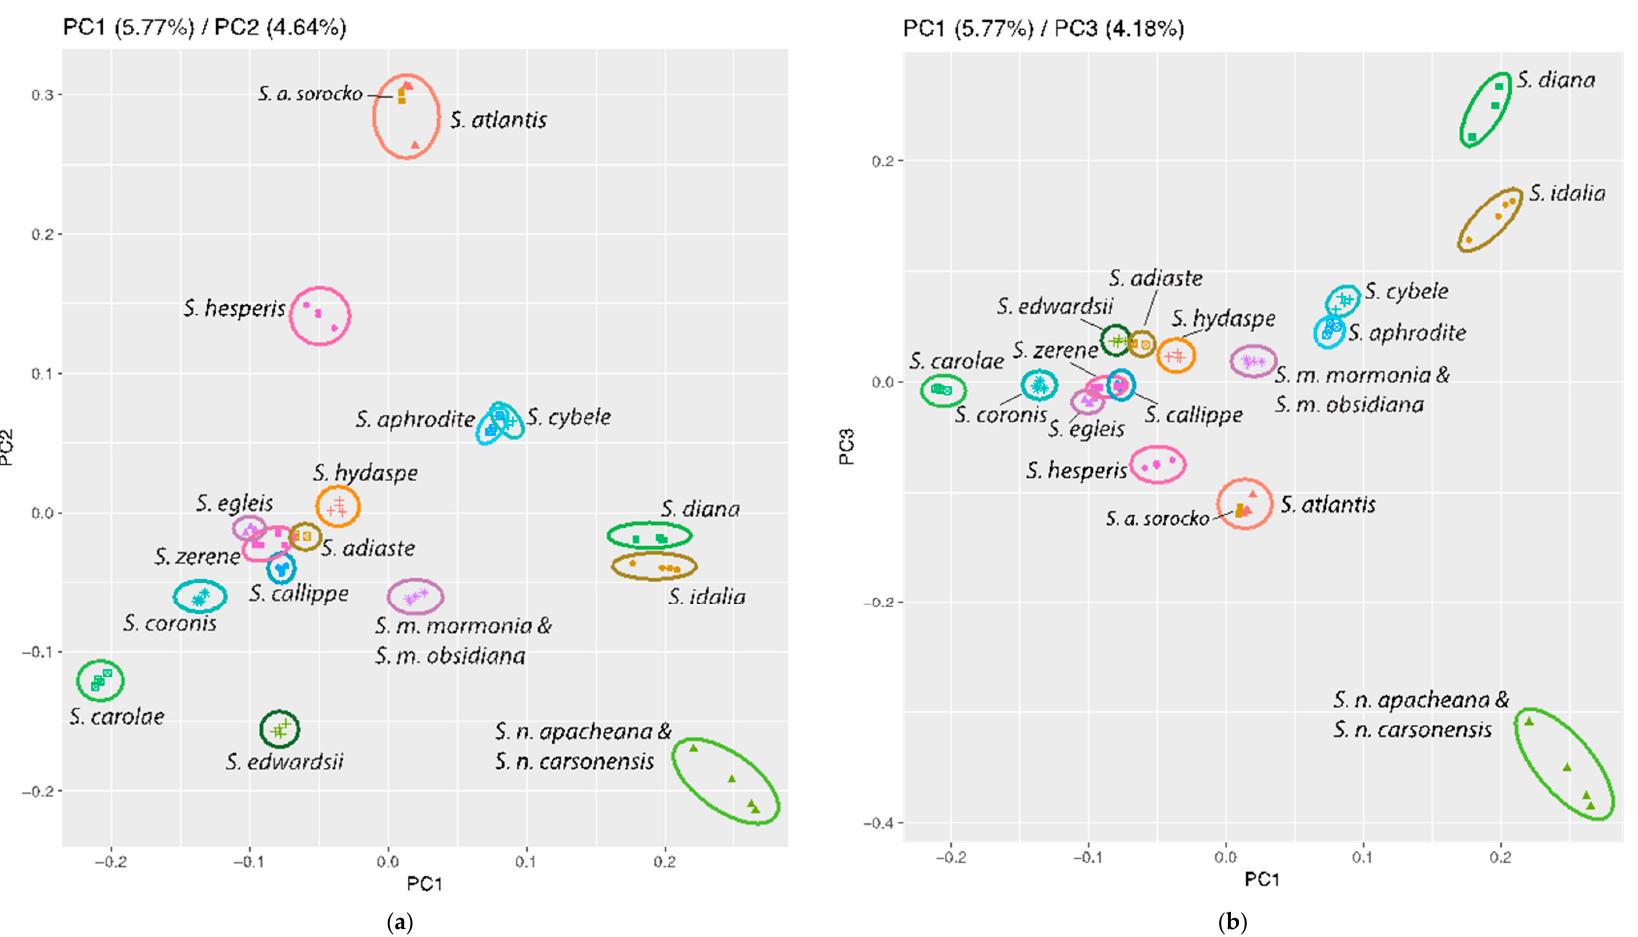
Figure 2. Principal component analyses of 17 hypothesized Speyeria species: ( a ) PC 1 vs. PC 2 which account for 5.8% and 4.6% of the variation in the overall dataset respectively; ( b ) PC 1 vs. PC 3 (4.2%).